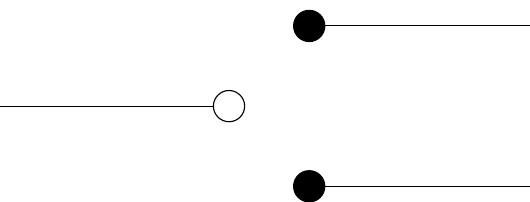
Figure 7: A 1-dimensional manifold which is locally Euclidean, but not Hausdorff. The line on the left is ( −∞ ,0 ) , and it does not include the point 0 (the white disk). ) and [ 0 ) , and they do include the The two lines on the right are [ 0 , + ∞ , + ∞ 1 1 2 2 points 0 and 0 respectively (the black disks). Both of these points are in the closure 1 2 of ( −∞ ,0 ) .